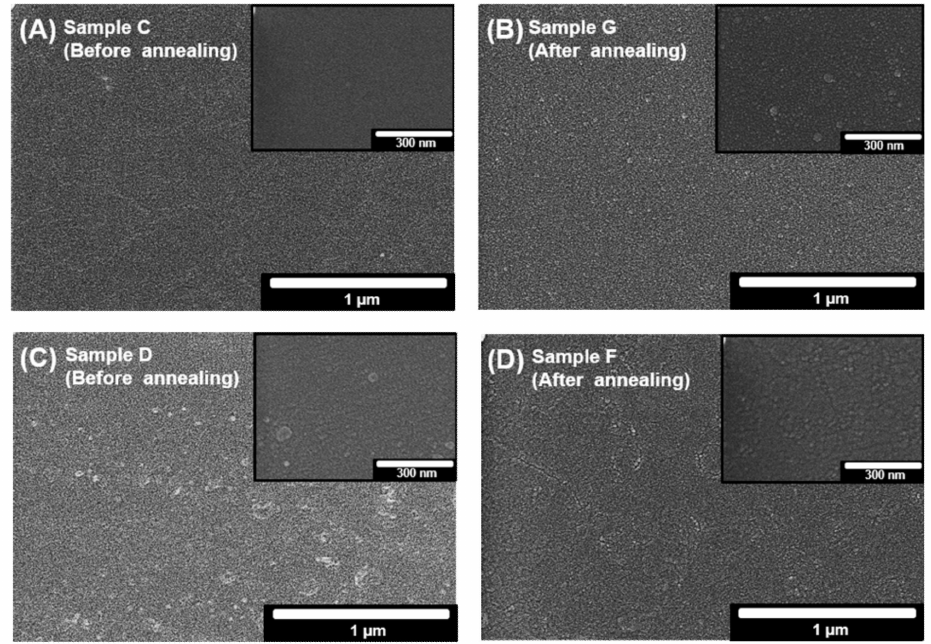
Figure 9. Surface SEM image of samples before and after annealing: ( A ) sample C (before), ( B ) sample G (after), ( C ) sample D (before), and ( D ) sample H